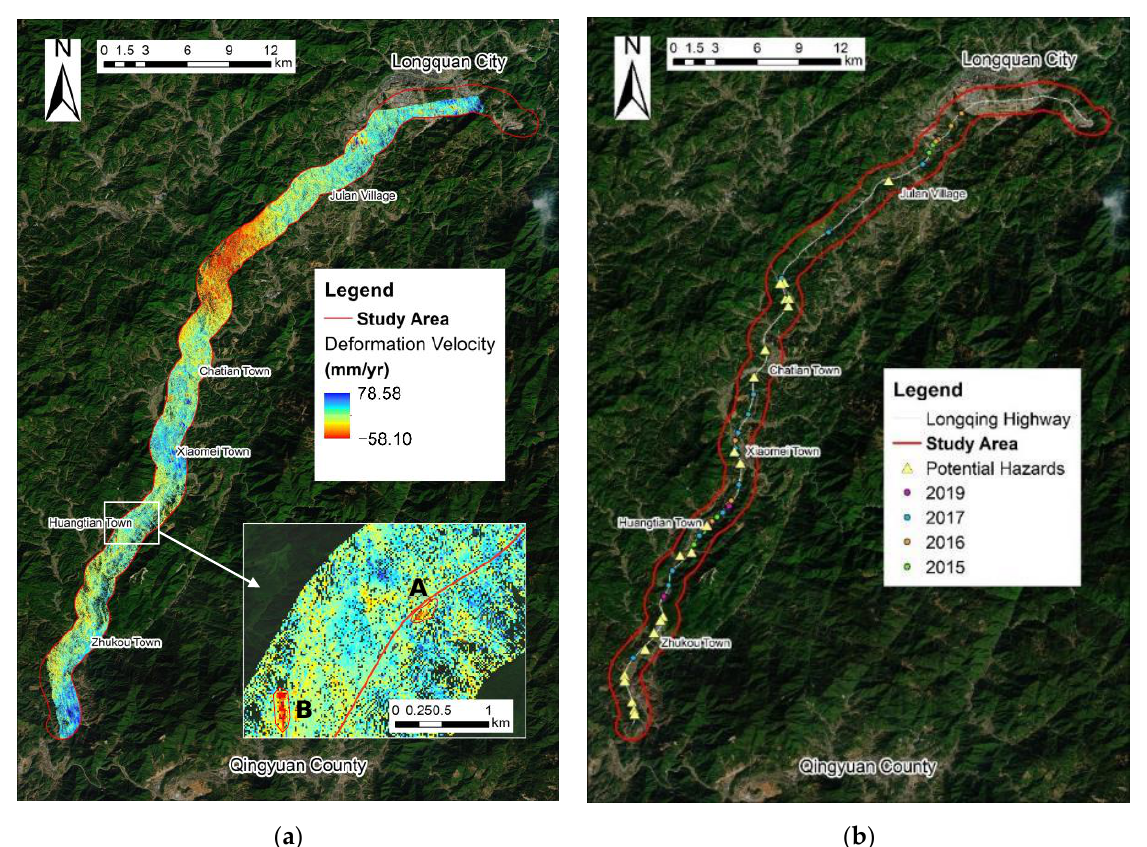
Figure 5. ( a ) Average ground deformation velocity of the study area; ( b ) potential hazards detected based on InSAR results.